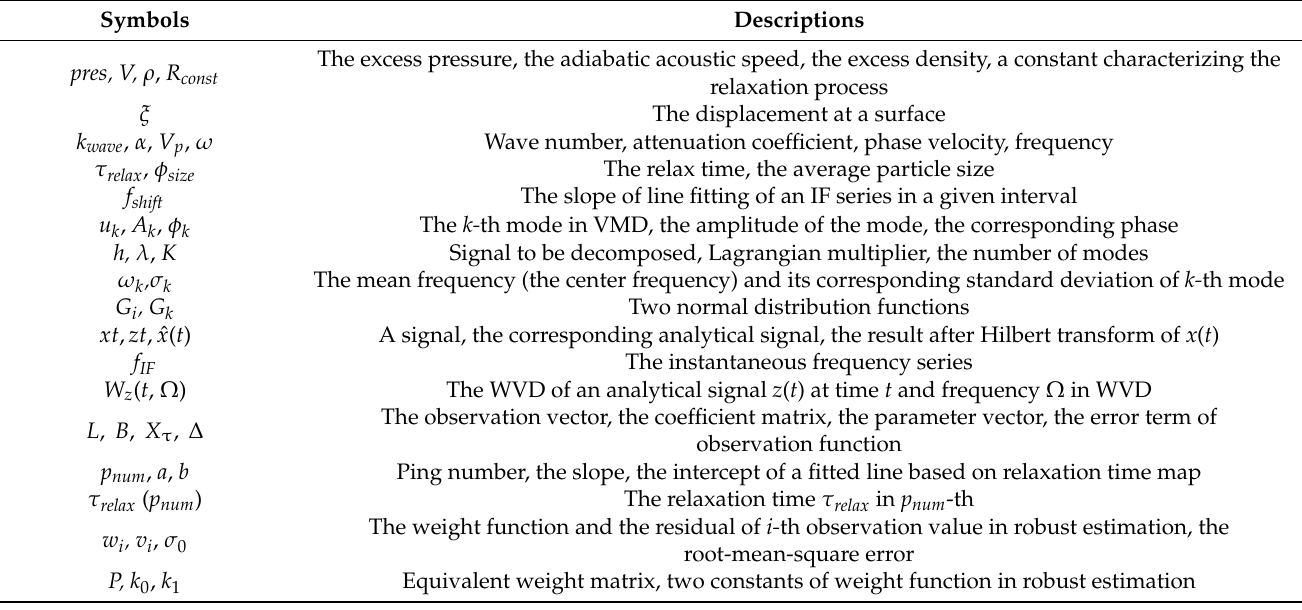
Figure 1. Flowchart of the proposed method. Table 1. Main symbols of variables used in the proposed